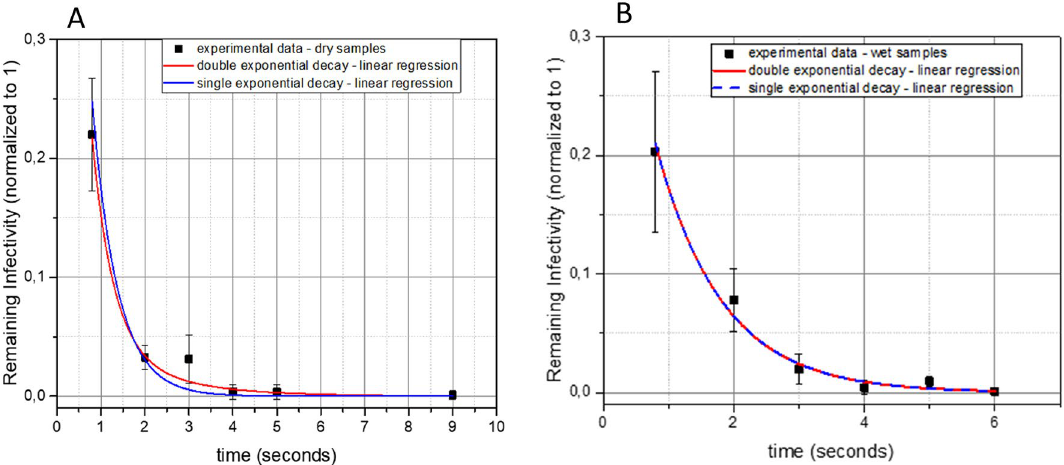
Figure 1. Reduction in infectivity of SARS-CoV-2 after exposure to UV-C irradiation. The virus was exposed to UV-C as dried droplets ( A ) or wet droplets ( B ). Each set of data (dry samples and wet samples) shows a decrease of the remaining infectivity as a function of time, normalized to 1. Blue lines indicate single exponential decay functions while red lines indicate double exponential decay